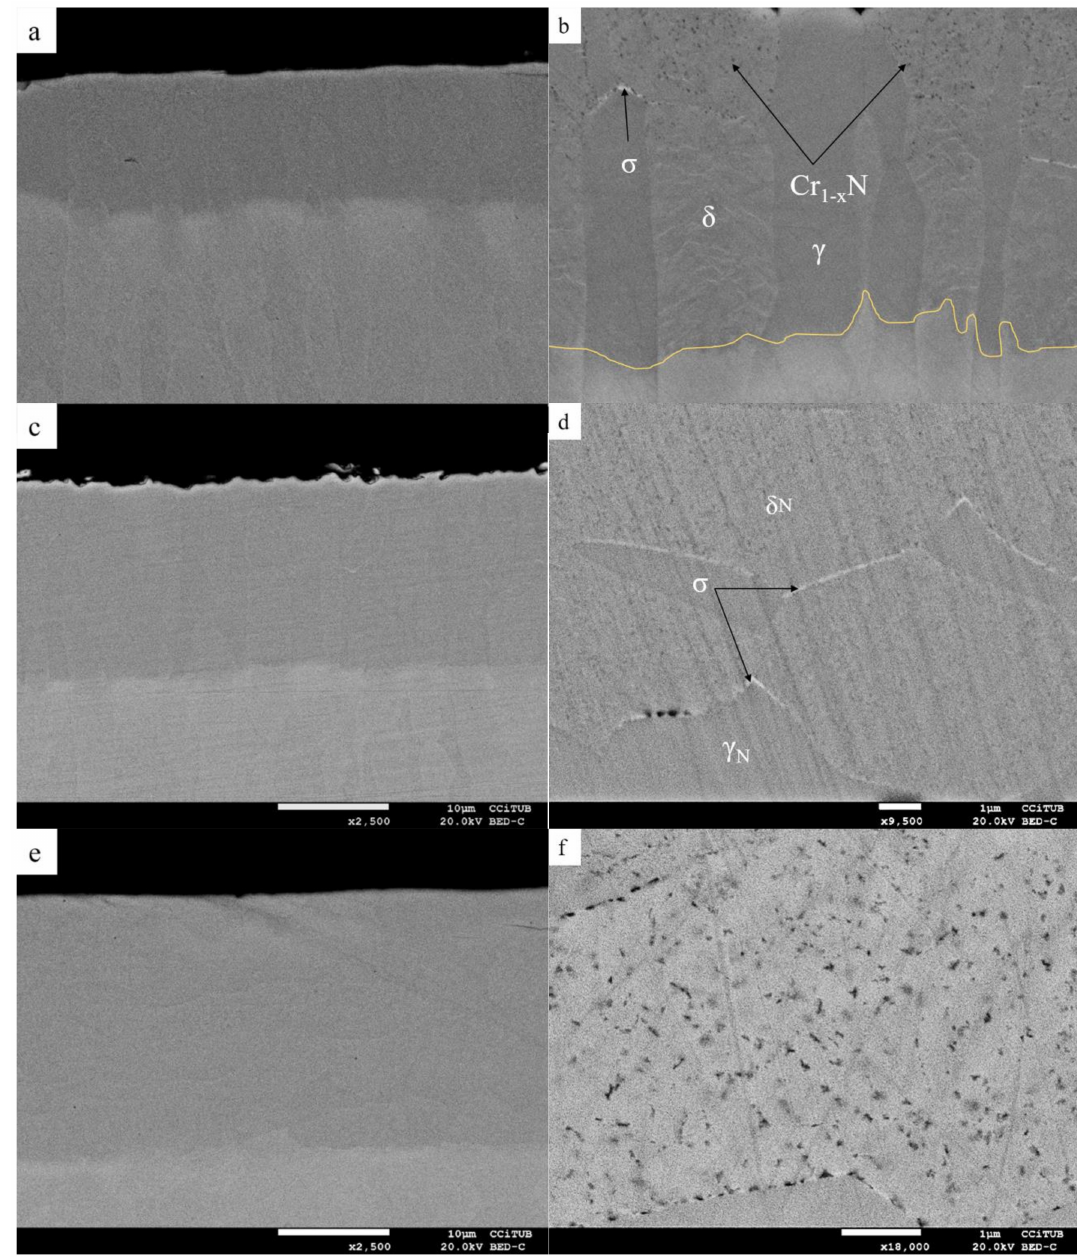
Figure 1. Backscattered electron (BSE) micrographs of super duplex stainless steel (SDSS) and duplex stainless steel (DSS) specimens after 10 h plasma nitriding at 520 ◦ C. ( a ) Cross-section nitride layer of the SDSS tube. ( b ) Details of the nitride layer indicating the austenite ( γ ) and ferrite ( δ ) phases, as well as the sigma phase and chromium nitrides. ( c ) Cross-section of the nitride layer of the SDSS plate. ( d ) Higher magnification of the nitride layer in ( c ) showing expanded austenite γ N and expanded ferrite δ N phases, as well as sigma phase in the boundaries. ( e ) Longitudinal section of the nitride layer of the DSS plate, and ( f ) higher magnification of the nitride layer (expanded ferrite δ N ) on the DSS plate showing the distribution of chromium nitrides